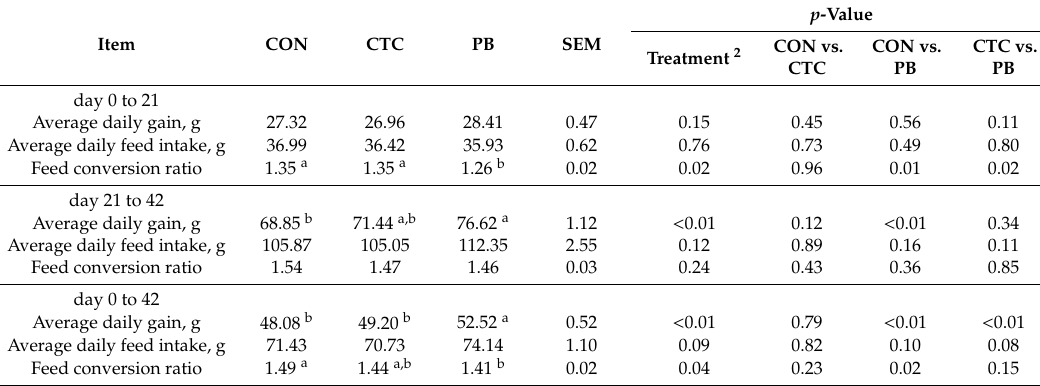
Table 3. E ff ects of probiotics on growth performance of broilers 1 .